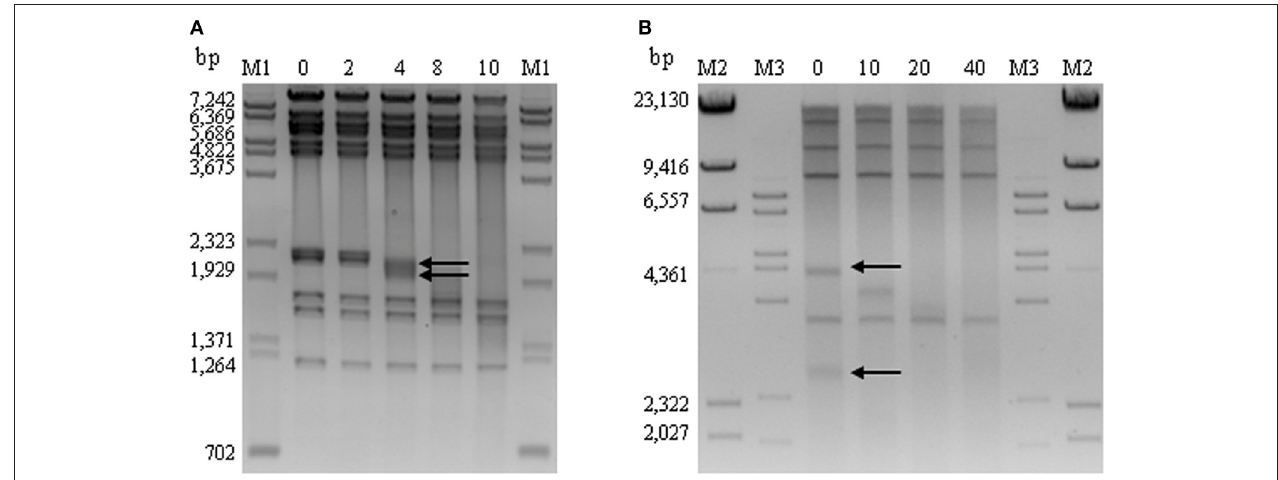
FIGURE 6 | Time-limited digestion with Bal 31 exonuclease of UAB_Phi78 and UAB_Phi87 DNA followed by digestion with Hin dIII and Spe I, respectively. Arrows indicate the sequentially degraded DNA bands of 2200 and 2080 bp for UAB_Phi78 (A) and of 4322 and 2819 bp for UAB_Phi87 (B) . M: marker lanes containing a mixture of λ DNA digested with Bst EII and ϕ X174 digested with Hin fI (M1), λ -DNA-digested Hin dIII (M2), and λ -DNA-digested Bst EII (M3). Sizes (bp) are indicated on the left side of the